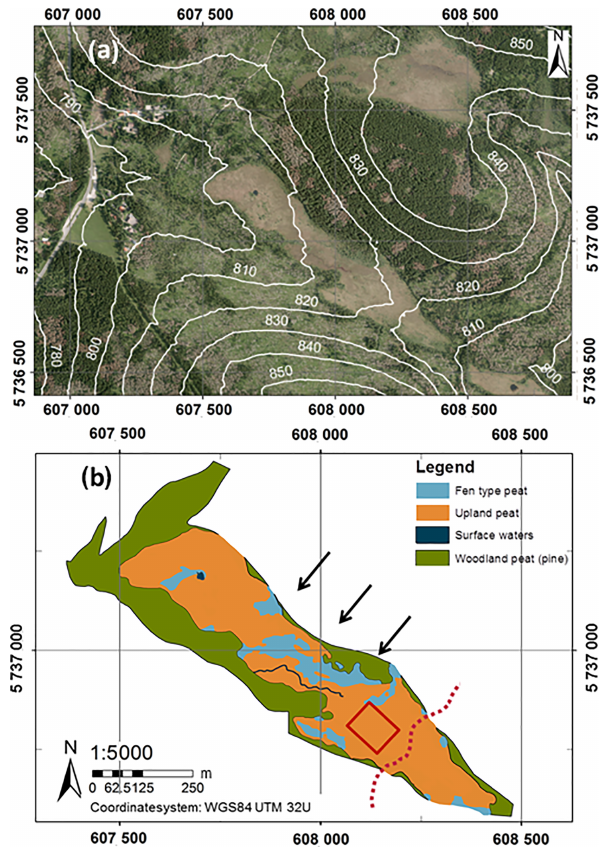
Figure 2. (a) Satellite image and elevation contours (ma.s.l.) of the Odersprungmoor; (b) vegetation mapping and characterization of the peatland. Black arrows indicate minerotrophic water influx into the peatland resulting in a higher proportion of fen type vegetation, the red dashed line is the approximate watershed divide, and the red box marks the sampling